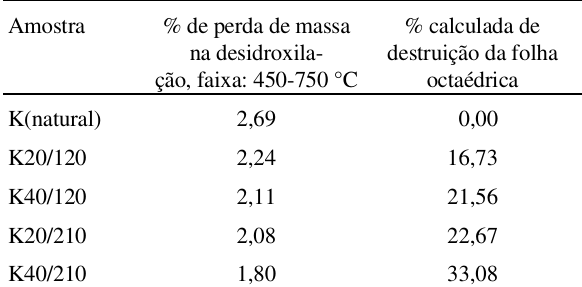
Tabela 3. Porcentagem de destruição da folha octaédrica, calculadas a partir das curvas TG.